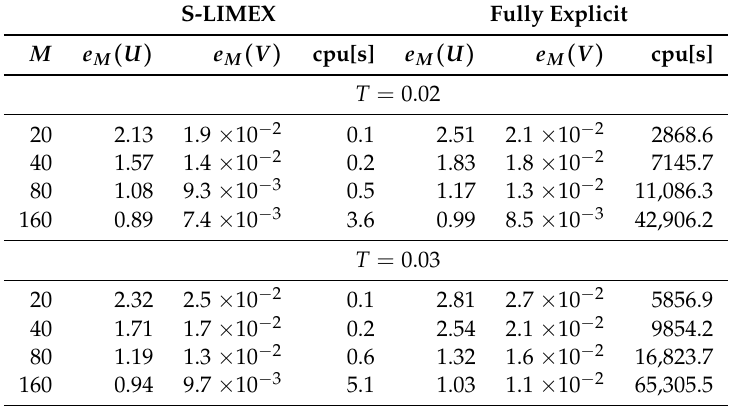
Table 2. Example 1, alternate scenario: Approximate L 1 errors e M ( u ) and e M ( v ) and CPU time for Strang LIMEX and Explicit